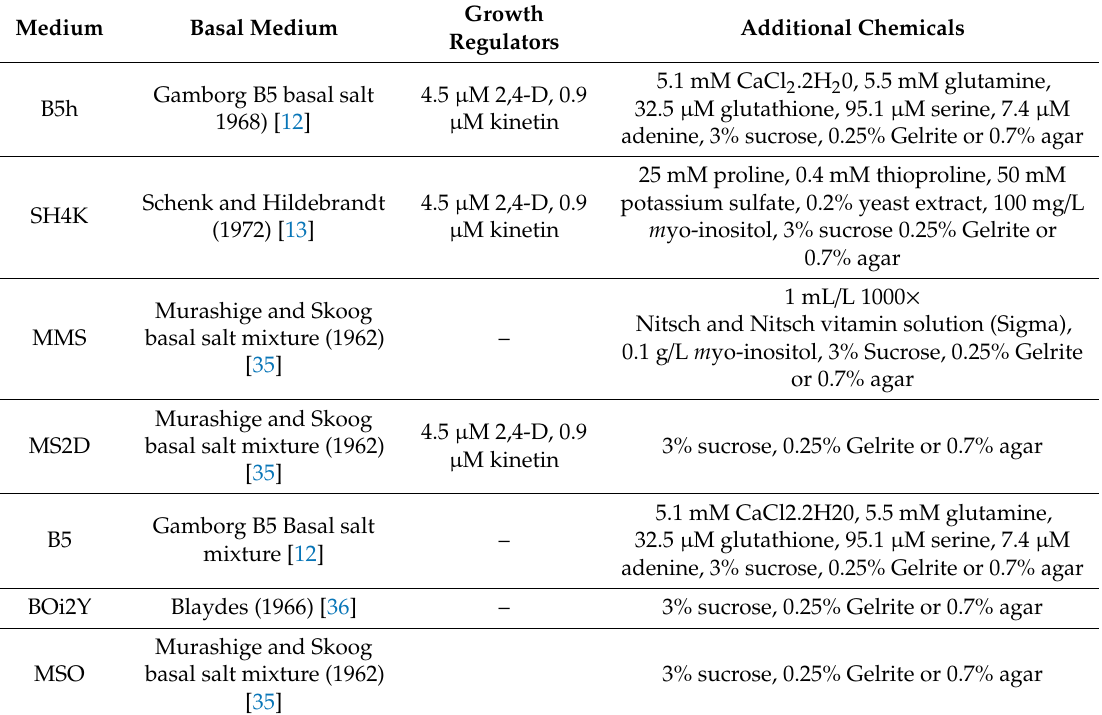
Table 3. Composition of the various media used in the study along with additional